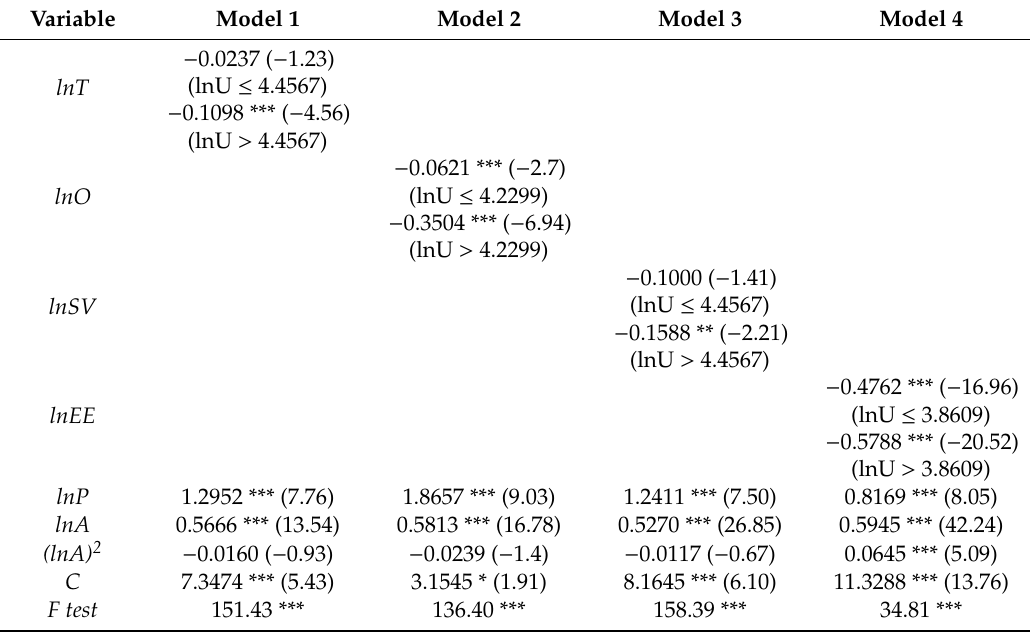
Table 5. Test results of the threshold regression models under the threshold variable of urbanization. Variable Model 1 Model 2 Model